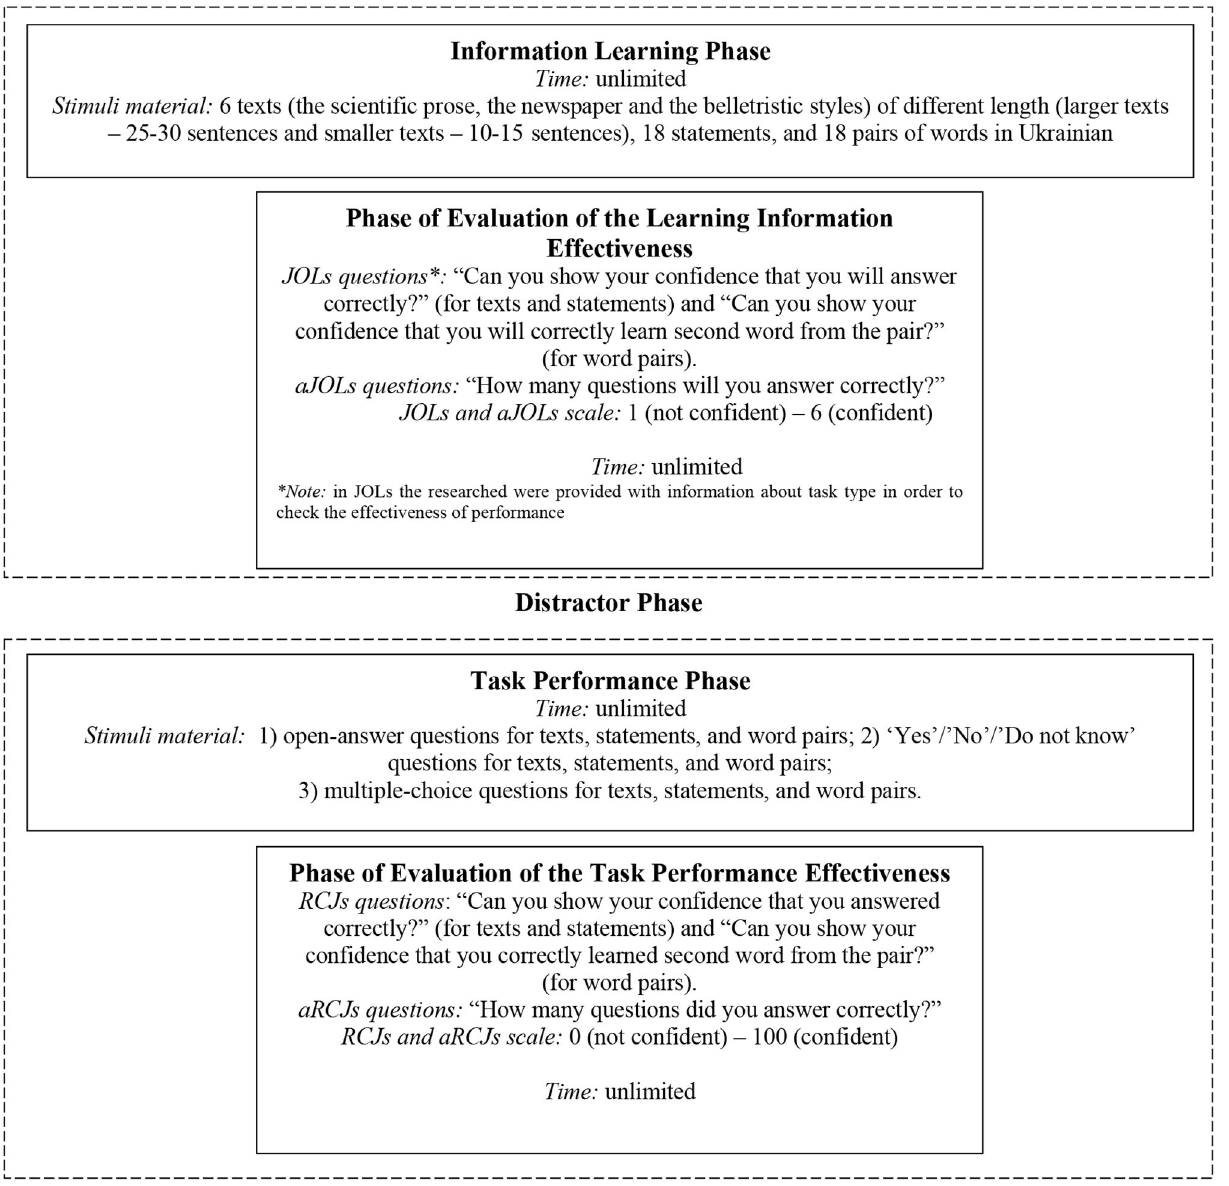
Figure 1. Scheme of the